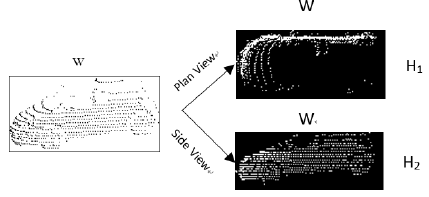
Figure 8. The matching